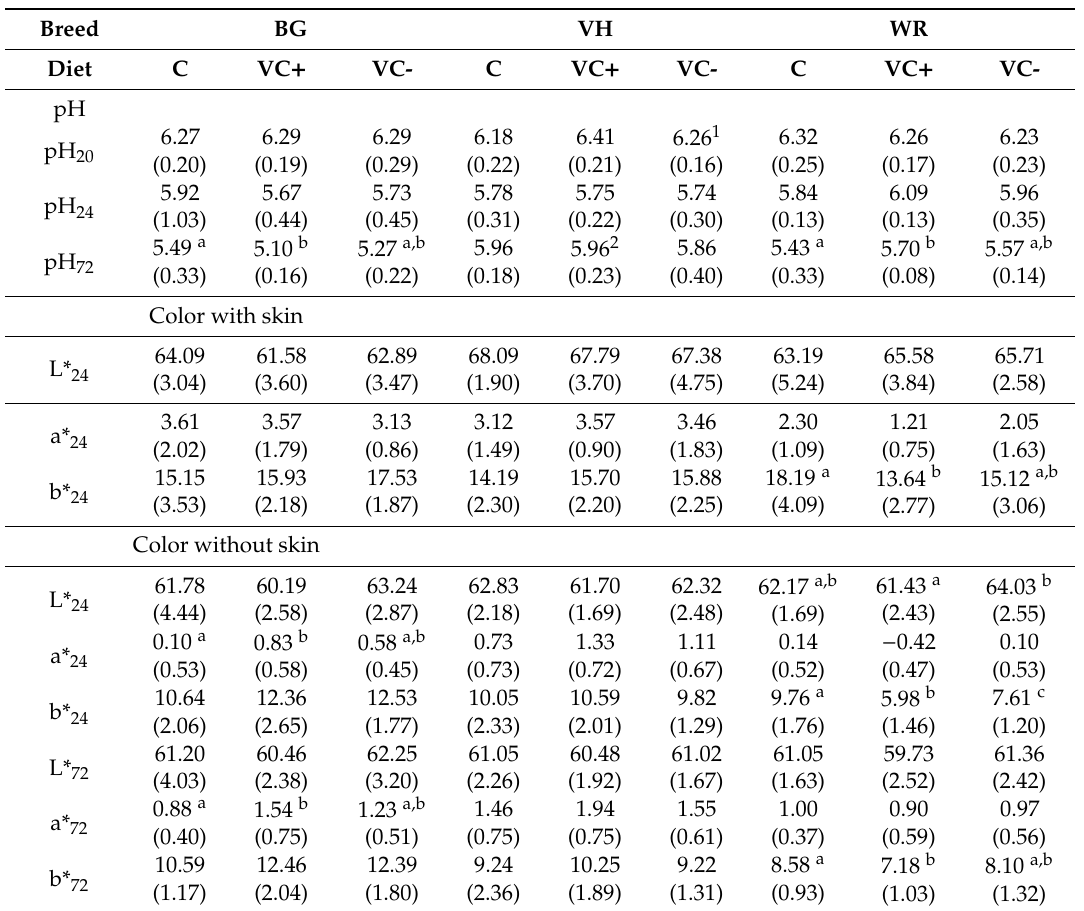
Table 2. Means (standard deviations) for physicochemical parameters ( n = 10): pH 20 , pH 24 , pH 72 , color (L* = lightness, a* = redness, b* = yelowness), storage loss, cooking loss, and shear force of breast muscle per breed (BG = Bresse Gauloise, VH = Vorwerkhuhn, WR = White Rock) and feed (C = control, VC + = high in vicin, VC- = low in